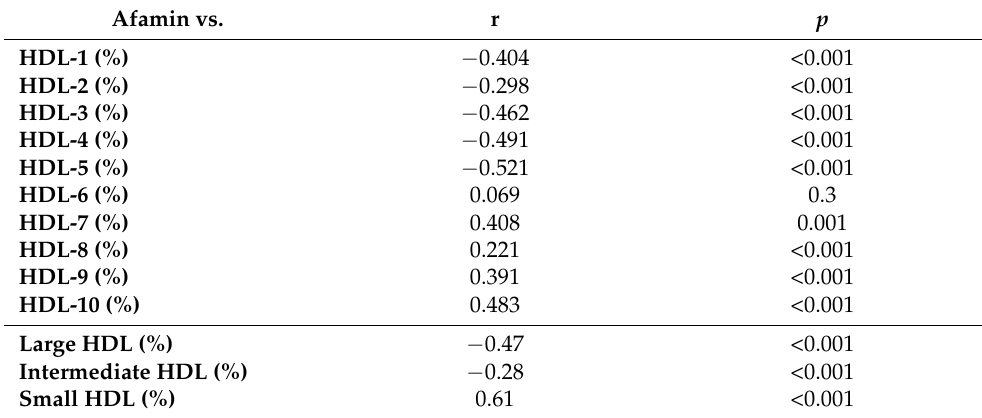
Table 3. Correlations between serum afamin and percentage of high-density lipoprotein (HDL) subfractions in overall subjects (n = 217). HDL subfractions were distributed by Lipoprint gel electrophoresis (Quantimetrix Corp., Redondo Beach, CA, USA) from serum samples. Afamin